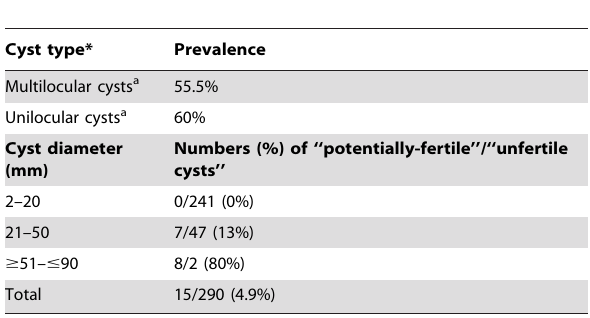
Table 3. The characteristics of hydatid cysts in yak by cyst type and size among 100 four-year-old necropsied animals, Datangma District, Ganzi County.